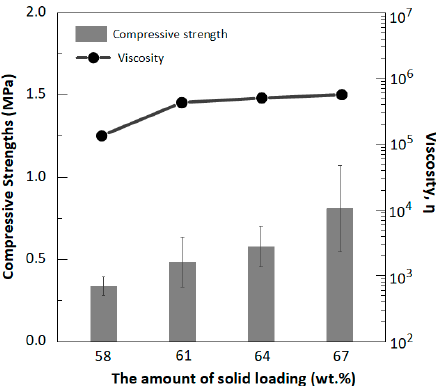
Figure 4. Viscosity at a shear rate of 0.01 s − 1 of the alumina slurries, and the compressive strengths with 58–67 wt. % solid loading .